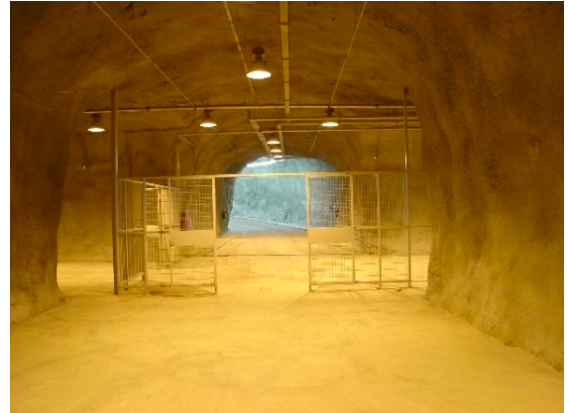
Figure 5. Underground UHWR tunnel entrance.